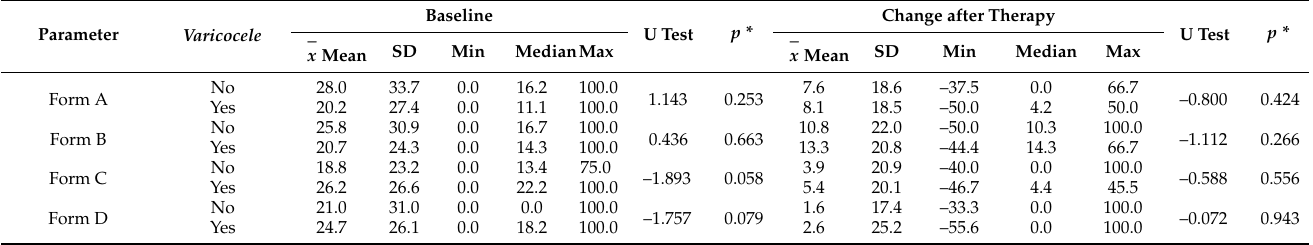
Table 6. Effects of treatment on percentages of sperm motility forms in the ejaculate in relation to the presence of varicocele